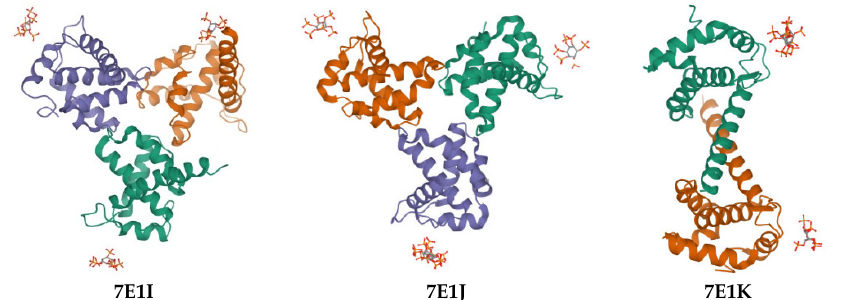
Figure 2. The X ‐ ray crystallographic structures of MA, which were recently released by our research group [44].